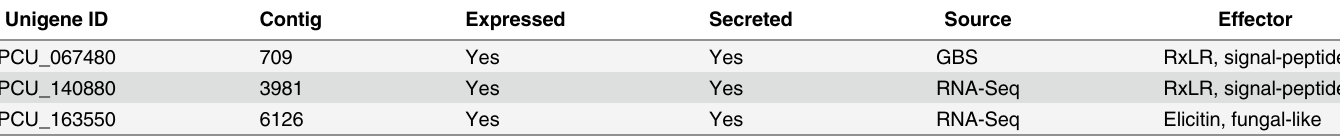
Table 3. Effector unigenes containing PCA-correlated SNPs. Unigene